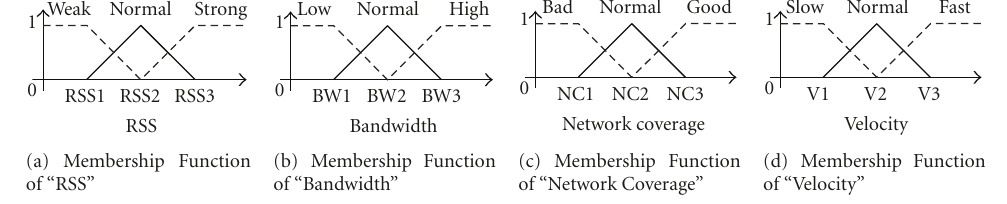
Figure 3: Membership functions of fuzzy logic system